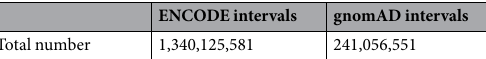
Table 4. Total number of intervals in our experiments.